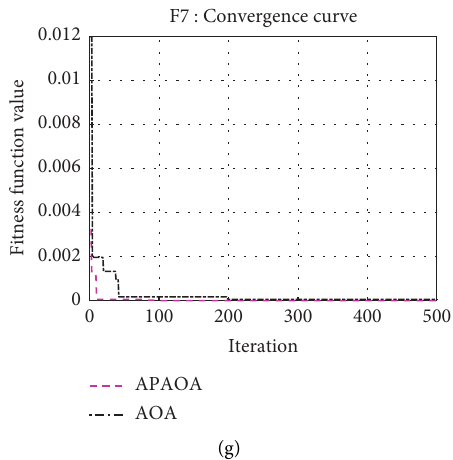
Figure 3: Comparison of convergence curves between APAOA and AOA in F1–F7.